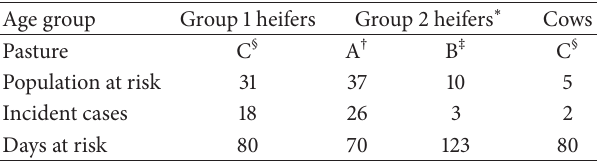
Table 4: Summary of population at risk, incident cases, and time at risk of Anaplasma marginale infection for cattle followed up to determine rate of A. marginale infection.